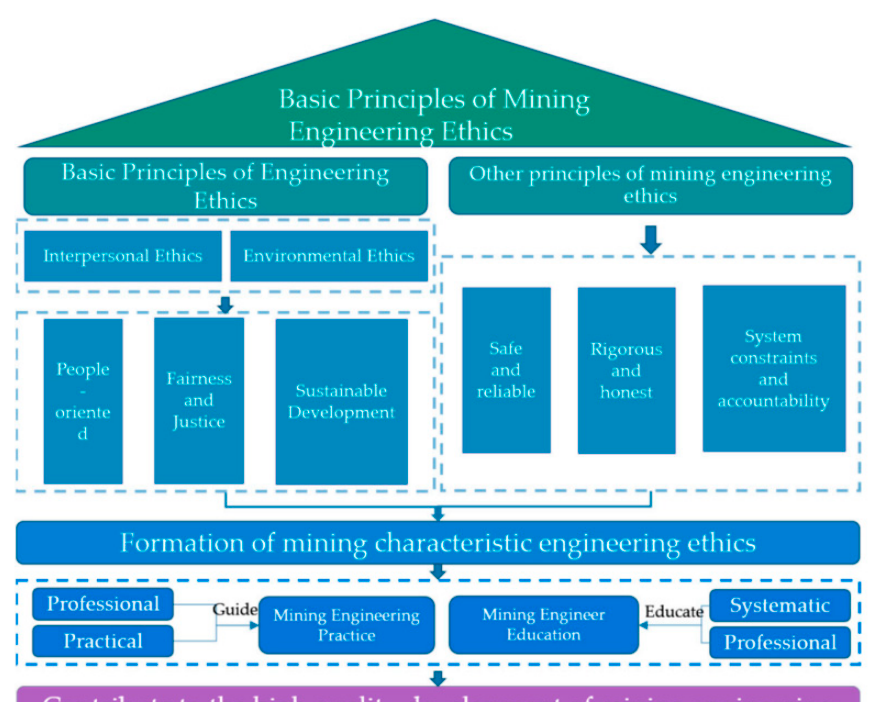
Figure 7. Basic principles of mining engineering ethics (Wang, F [54]).